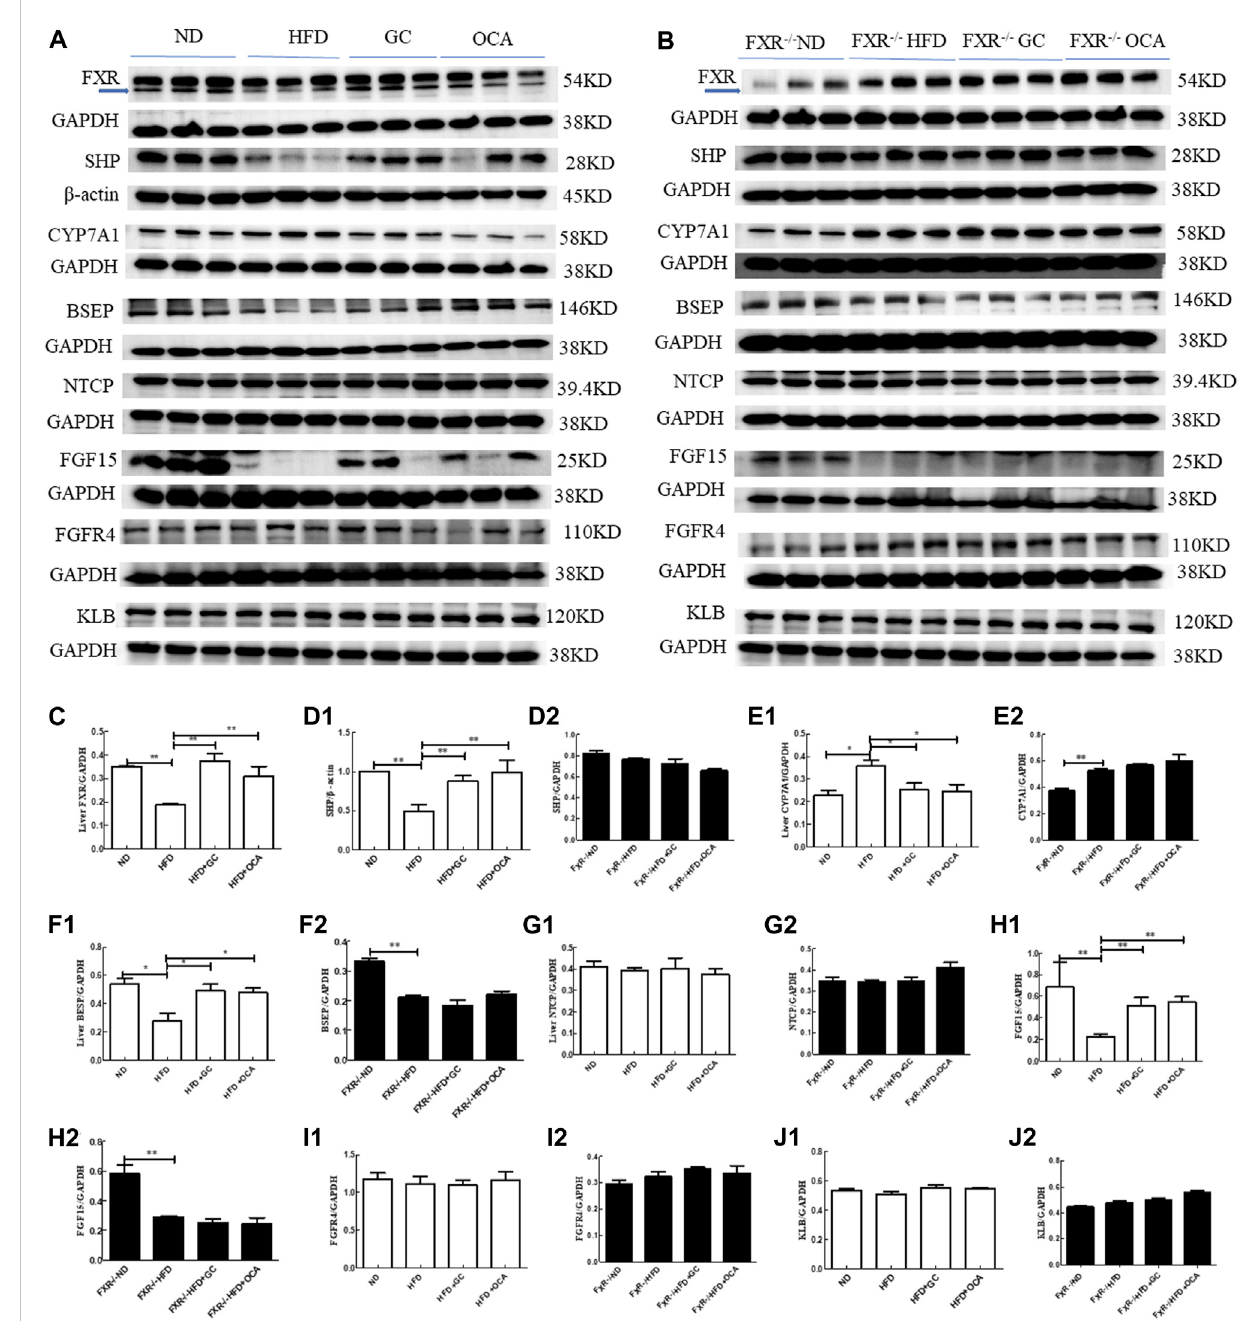
FIGURE 7 Changes in the liver tissue levels of FXR, SHP, CYP7A1, BSEP, FGFR4, NTCP, and KLB proteins and ileal tissue levels of FGF15 with intervention of GC or OCA in wild type and FXR − / − mouse NAFLD models. (A) Western blot picture of wild-type mice. (B) Western blot picture of FXR − / − mice. (C) Quanti fi ed dataofFXRproteininlivertissues. (D1,D2) Quanti fi eddataofSHPproteininlivertissues. (E1,E2) Quanti fi eddataofCYP7A1proteininlivertissues. (F1,F2) Quanti fi ed data of BSEP protein in liver tissues. (G1, G2) Quanti fi eddata ofNTCP protein in liver tissues. (H1, H2) Quanti fi ed data of FGF15 protein in ileal tissues; (I1, I2) Quanti fi ed data of FGFR4 protein in liver tissues. (J1, J2) Quanti fi ed data of KLB protein in liver tissues. Abbreviations: NAFLD, non- alcoholic fatty liver disease; ND, normal diet; HFD, high-fat diet; GC, geniposide and chlorogenic acid combination treatment; OCA, obeticholic acid; FXR − / − , FXR knockout.* p < 0.05 and ** p < 0.01 ( n = 3 per